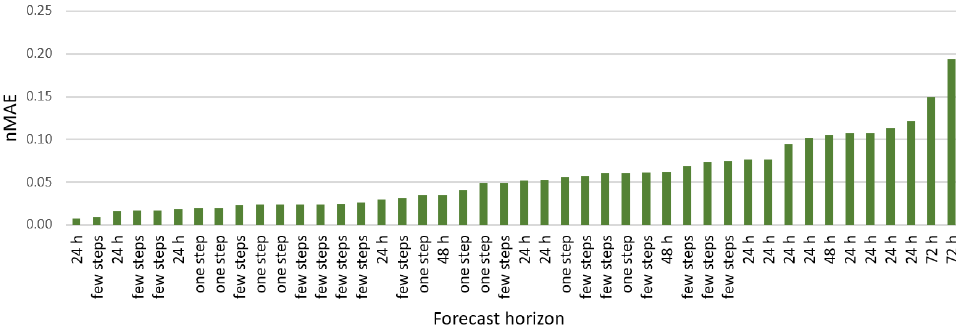
Figure 10. nMAE errors with a note on forecasting horizon, in ascending order.